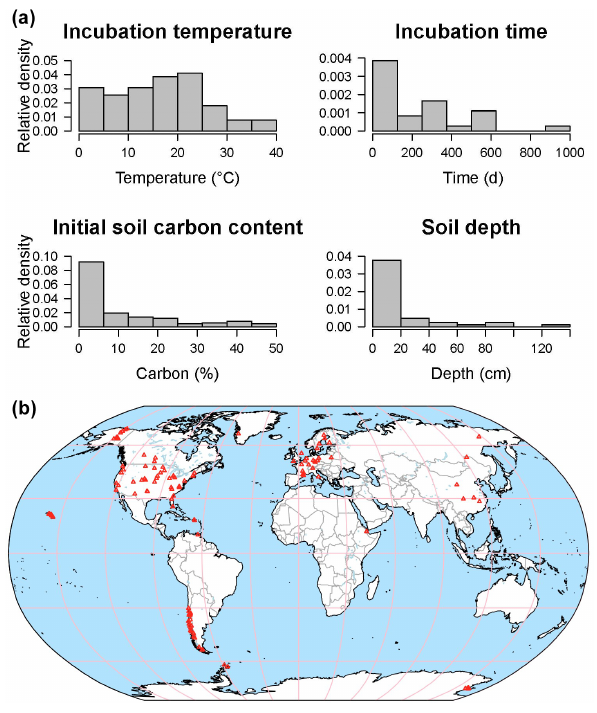
Figure 6. Data distribution histograms of incubation temperature, time, initial soil C content, and soil depth for available incubation data in SIDb 1.0 (a) . Map of currently available incubation stud- ies (b)